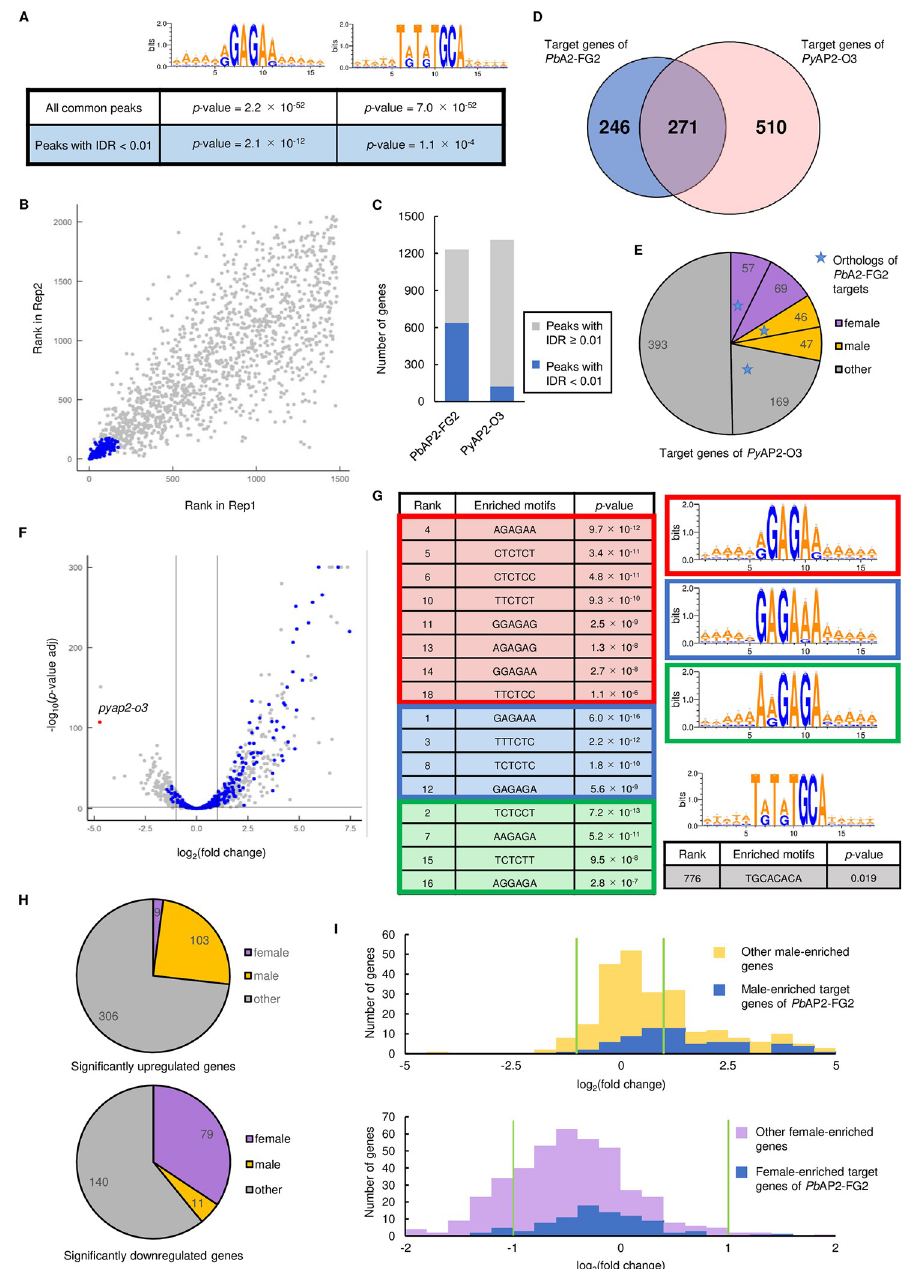
Fig 9. Reassessment of the ChIP-seq and RNA-seq data for the study of Py AP2-O3. (A) Enrichment of RGAGAR and TRTRTGCA motif in the peak region identified by ChIP-seq analysis of Py AP2-O3. The logos were depicted by WebLogo 3. (B) IDR1D analysis between the ChIP-seq experiment 1 and 2 of Py AP2-O3. Peaks with IDR < 0.01 are indicated as blue dots. (C) Ratio of peaks with IDR < 0.01 in all peaks identified in ChIP-seq of Pb AP2-FG2 and Py AP2-O3. (D) A Venn diagram showing number of genes common in the targets of Pb AP2-FG2 and Py AP2-O3. (E) Classification of the target genes of Py AP2-O3 into sexual stage-enriched gene sets. The number of target genes common for Py AP2-O3 and Pb AP2-FG2 are indicated with a blue star for each set. (F) A volcano plot showing DEGs in pyap2-o3 -null parasite compared to Py WT. Blue dots represent orthologs of the target genes of Pb AP2-FG2, and a red dot indicates pyap2-o3 . A horizontal line indicates a p -value of 0.05, and two vertical lines indicate log 2 (Fold Change) of -1 and 1. (G) Six-bp DNA motifs enriched within the upstream region (300 to 1200 bp from ATG) of genes upregulated in pyap2-o3 -null parasite. (H) Classification of significantly upregulated and downregulated genes into sexual stage-enriched gene sets (top and bottom, respectively). (I) Histograms showing distribution of log 2 (Fold Change) values in pyap2-o3 -null parasite for female and male-enriched genes (top and bottom, respectively). Green lines indicate log 2 (Fold Change) of -1 and